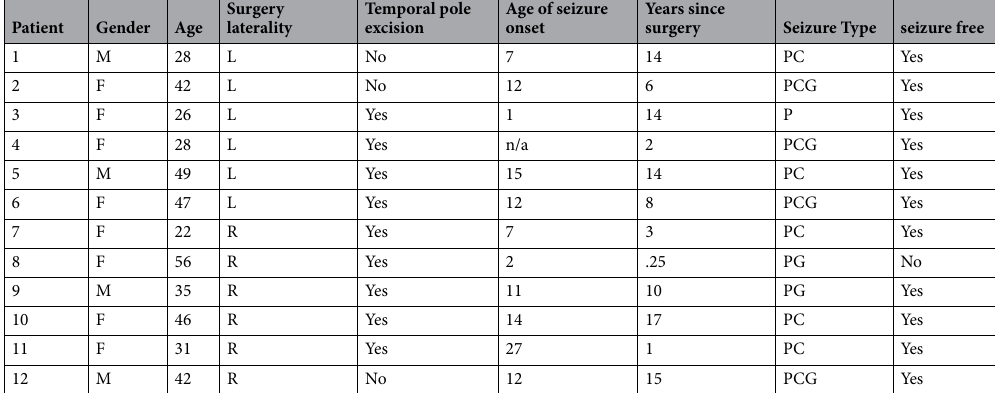
Table 2. Summary of patient group. Age is in years at the time of the experiment. All patients underwent unilateral removal of the amygdala and hippocampus either on the left (L) or on the right (R). Patients whose surgery included the anterior temporal pole are indicated as “yes’ or “no” in the 5th column. Type of seizures are indicated as P = partial simple, PC = partial complex, PCG = partial complex secondarily generalized. n/a = not